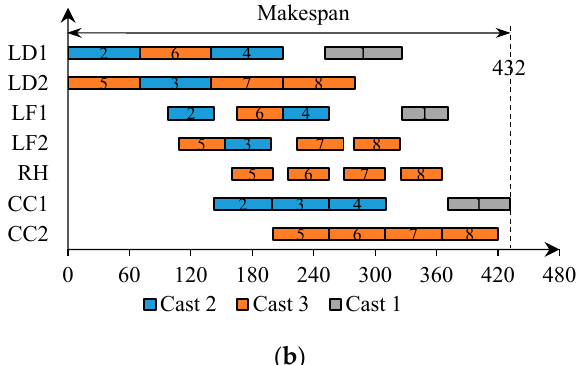
Figure 3. Two-level decoding procedure for the SCC scheduling problem. ( a ) FIFO-based forward heuristic; ( b ) Backward heuristic.